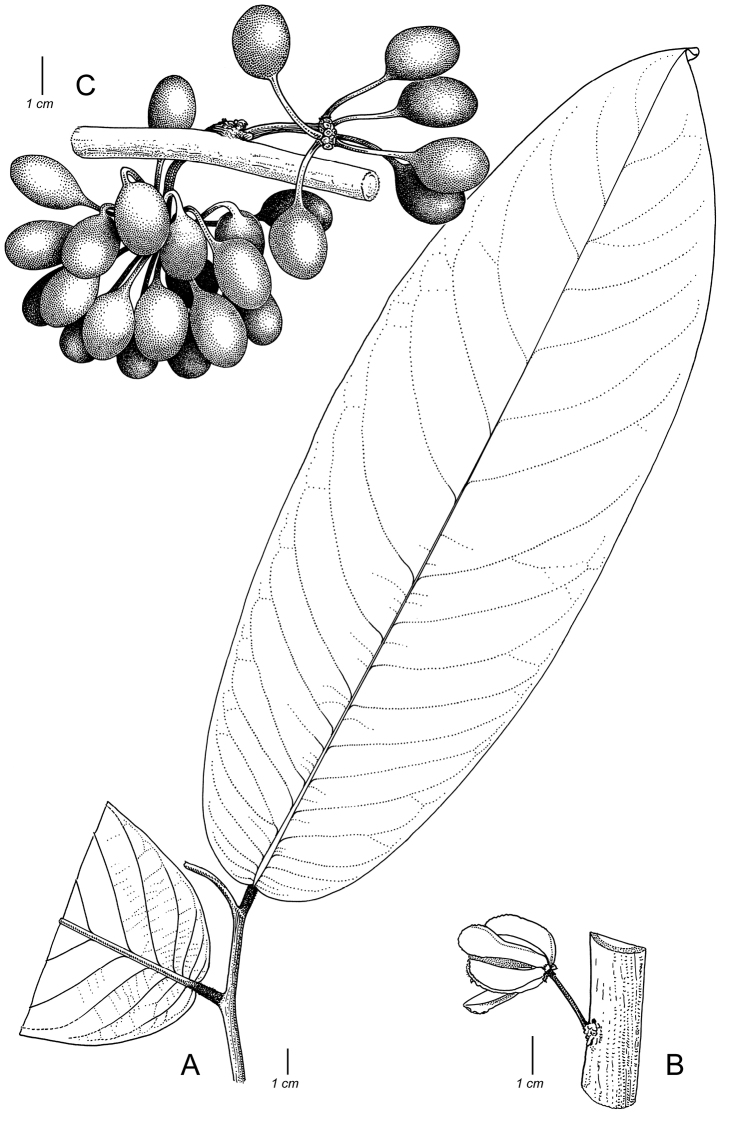
Cremastospermavenezuelanum Pirie. a leaves b flower c immature fruit (a, cEdwards 397bSteyermark 94314).